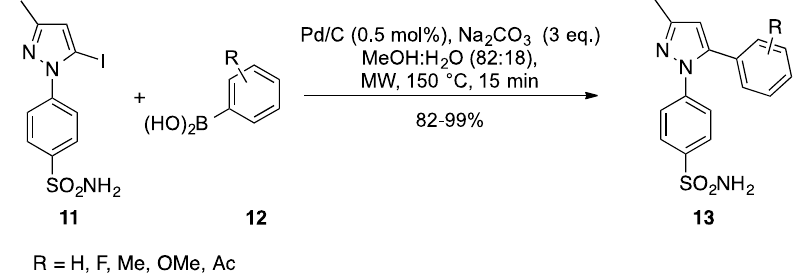
Scheme 5. Solution-phase synthesis of potential COX-2 inhibitors.